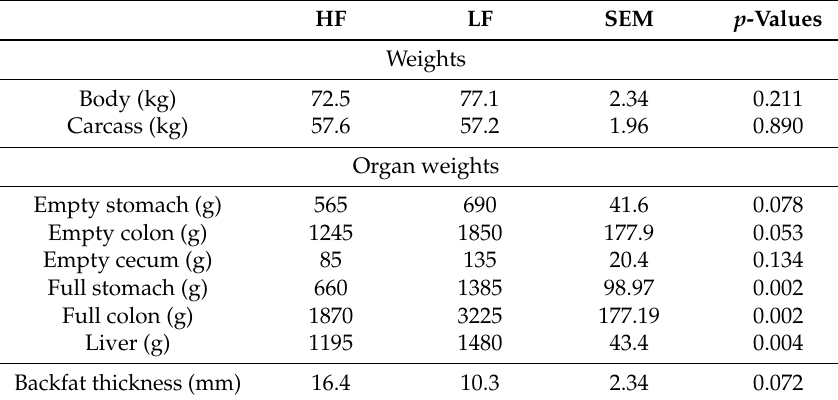
Table 3. Zootechnical data.